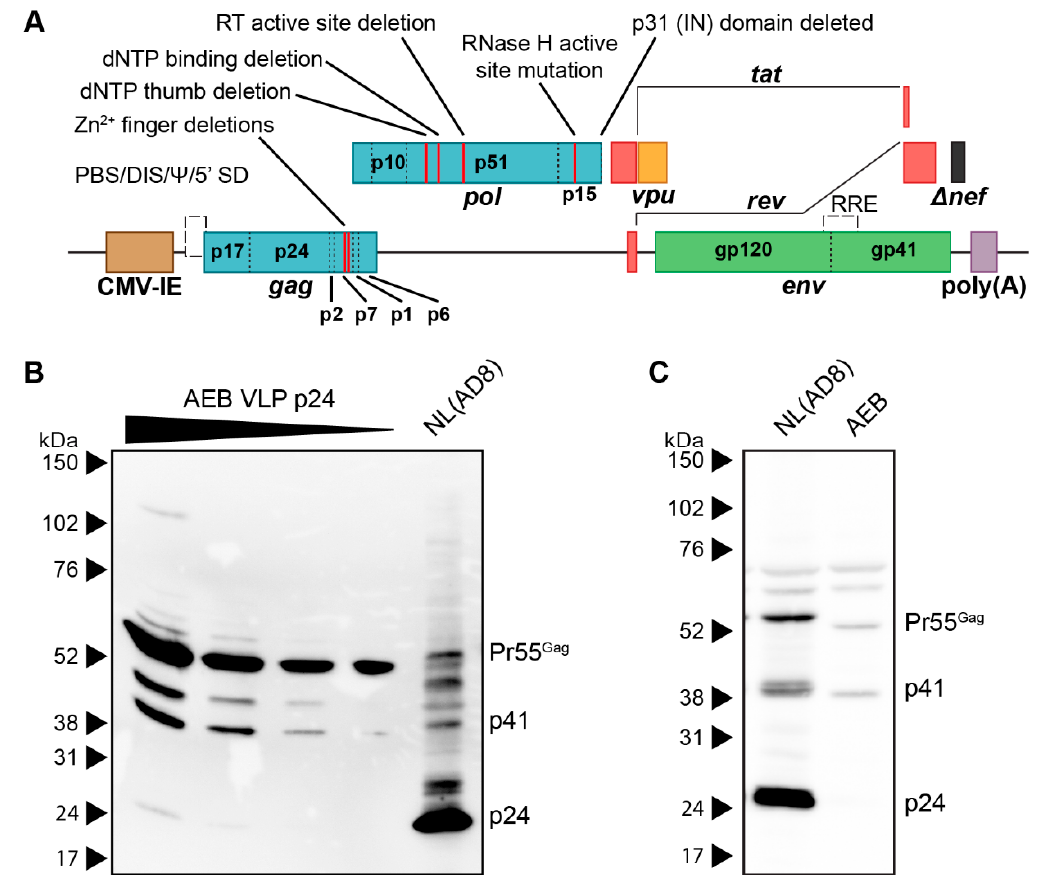
Figure 1. Genetic organisation and Gag processing in AEB VLPs. ( A ) Schematic representation of the AEB VLP expression cassette. Red lines within gag and pol indicate the locations of deletions and mutations, and the specific mutation is described by the indicated text. CMV-IE, cytomegalovirus immediate early promoter; poly(A), polyadenylation signal; PBS, primer binding site; DIS, dimer initiation site; Ψ , retroviral Psi packaging element; 5’ SD, 5’ splice donor; RRE, Rev responsive element; RT, reverse transcriptase; IN, integrase. ( B ) Representative Western blot using anti-p24 (#24-4) on NL(AD8) virus and 2-fold increments of AEB VLPs. ( C ) Representative Western blot using anti-p24 (#24-4) on equal volumes of cell lysate (from cell number-equalized samples) from cells expressing NL(AD8) and AEB VLPs. For both ( B ) and ( C ), 8–16% SDS-PAGE was used to resolve samples. Positions of Gag proteins are indicated on the right. Protein sizes were indicated by Amersham ECL Full-Range Rainbow Molecular Weight Markers (GE Healthcare Life Sciences) and are shown on the left.